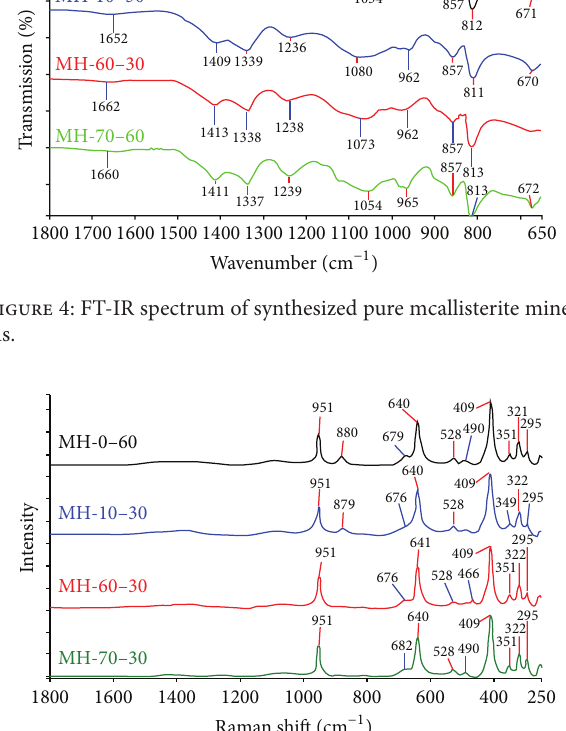
were 53.25 ± 1.20 % in MH-70-60, 54.17 ± 0.87 % in